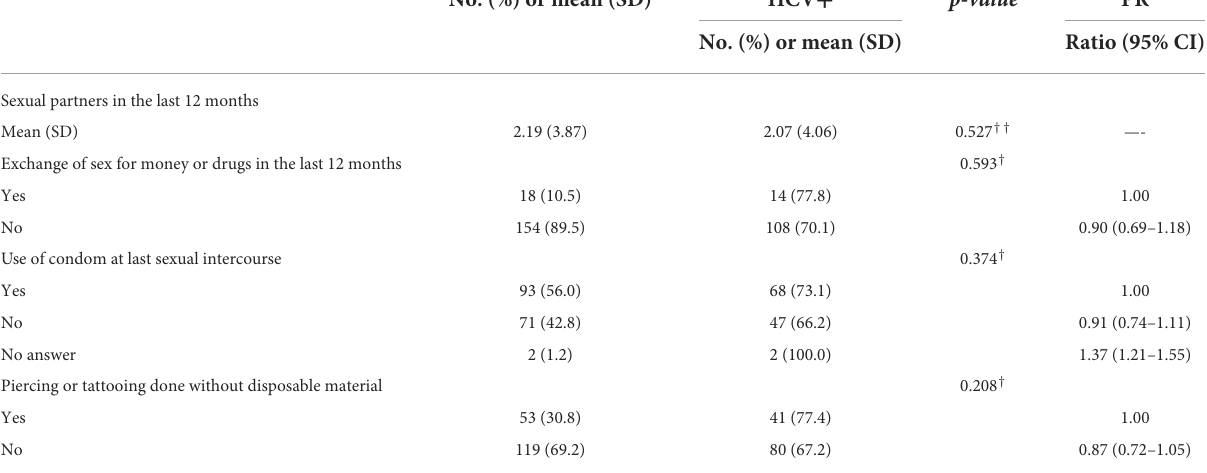
TABLE 3 Other risk factors for